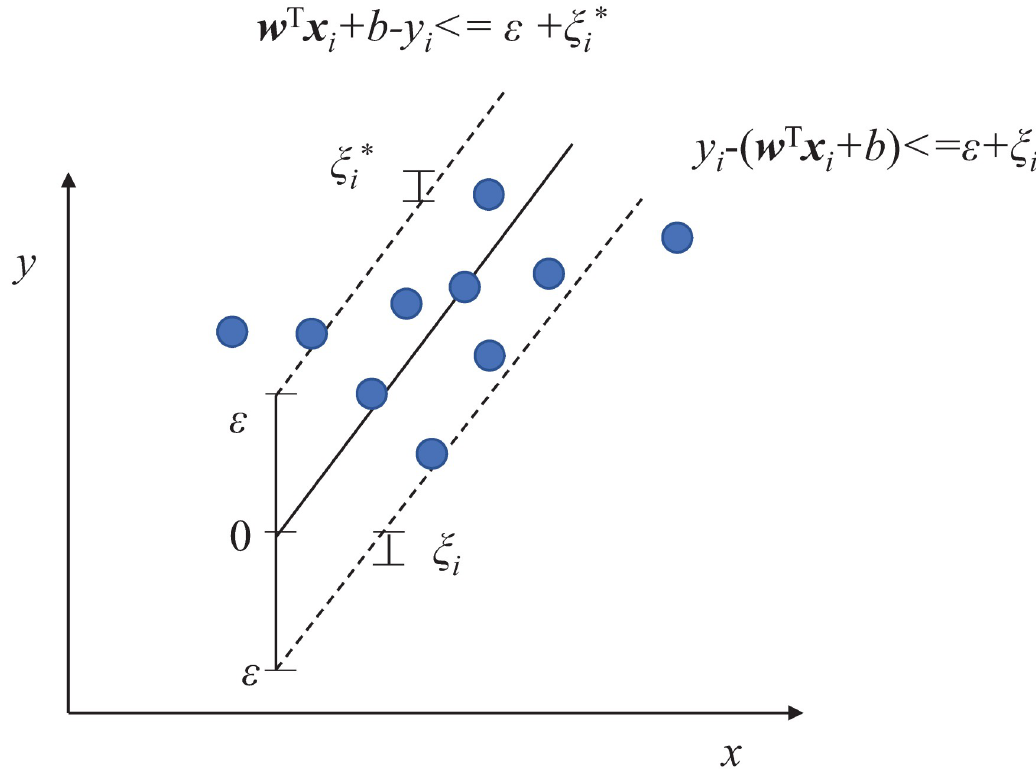
Fig 5. ε -SVM regression with the ε -insensitive hinge loss, meaning there is no penalty to errors within the ε margin.